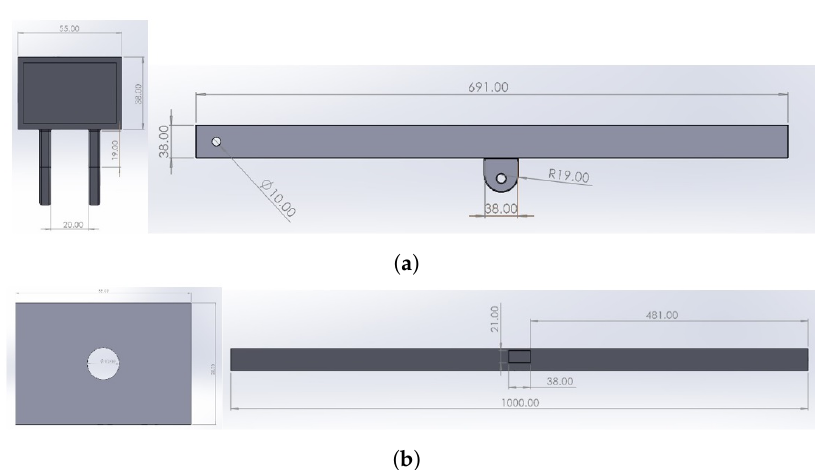
Figure 6. Detailed dimensions for ( a ) upper support bar and ( b ) front support bar. Stretcher assembly consists of two rods and fabric that are laid on the bed and are attached with U bars connected with the upper frame with the help of chains for lifting the patient, as shown in Figure 7.